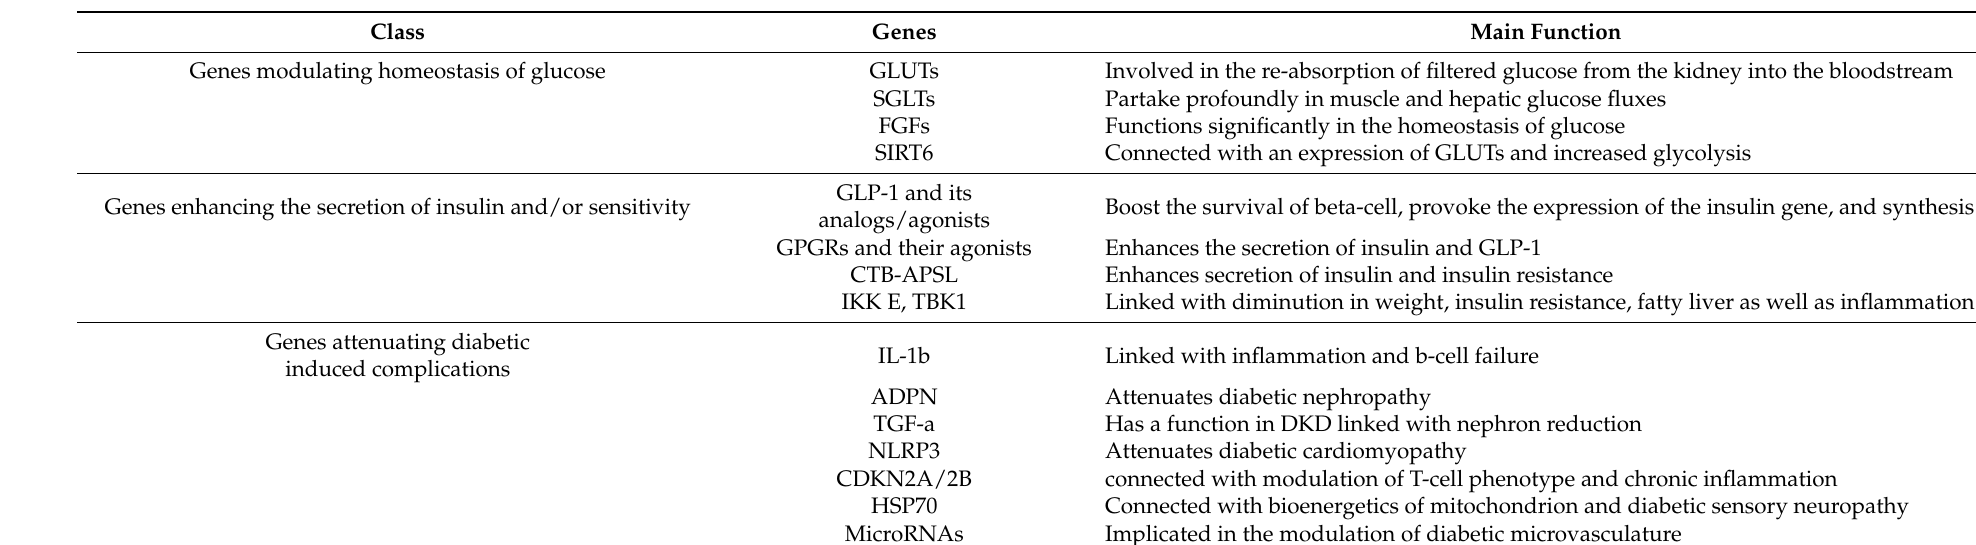
Table 1. Promising targets that can be employed for T2DM gene